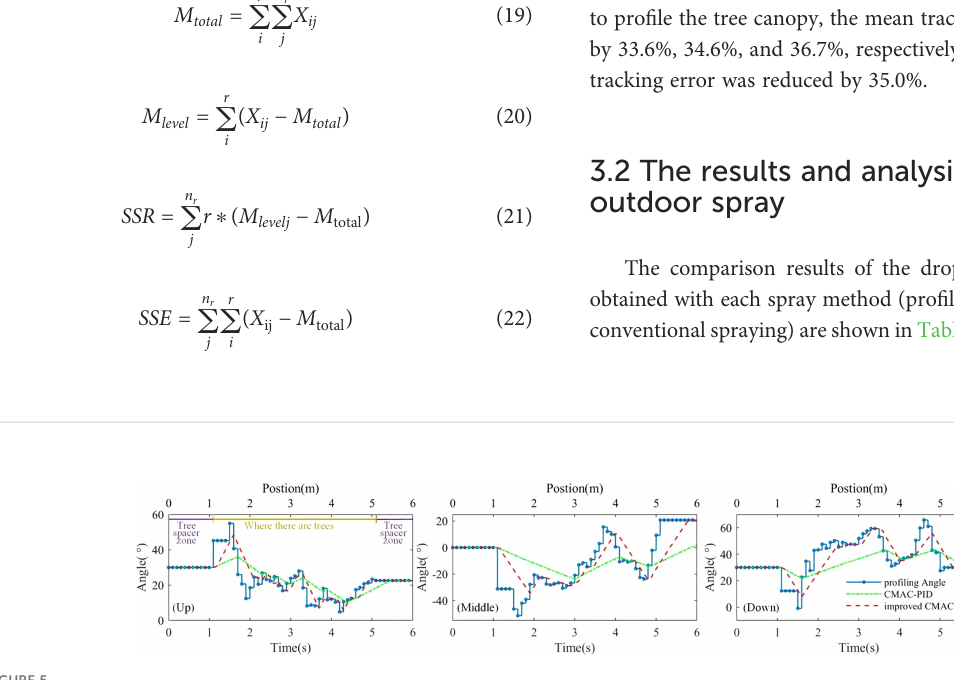
FIGURE 5 The tracking curves of the sprayer pro fi ling up, middle and down layer of the tree canopy with different control